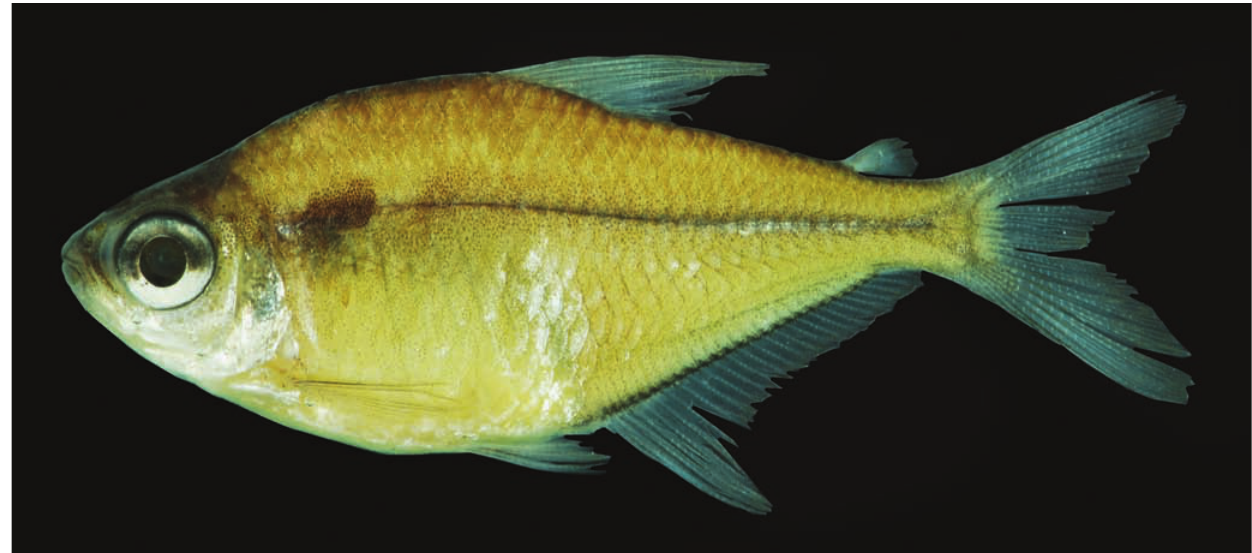
Fig. 1. Hemigrammus machadoi , INPA 39889, holotype, 30.4 mm SL, Brazil, Mato Grosso State, Pontes e Lacerda, igarapé Barreiro, tributary of rio Guaporé, rio Madeira